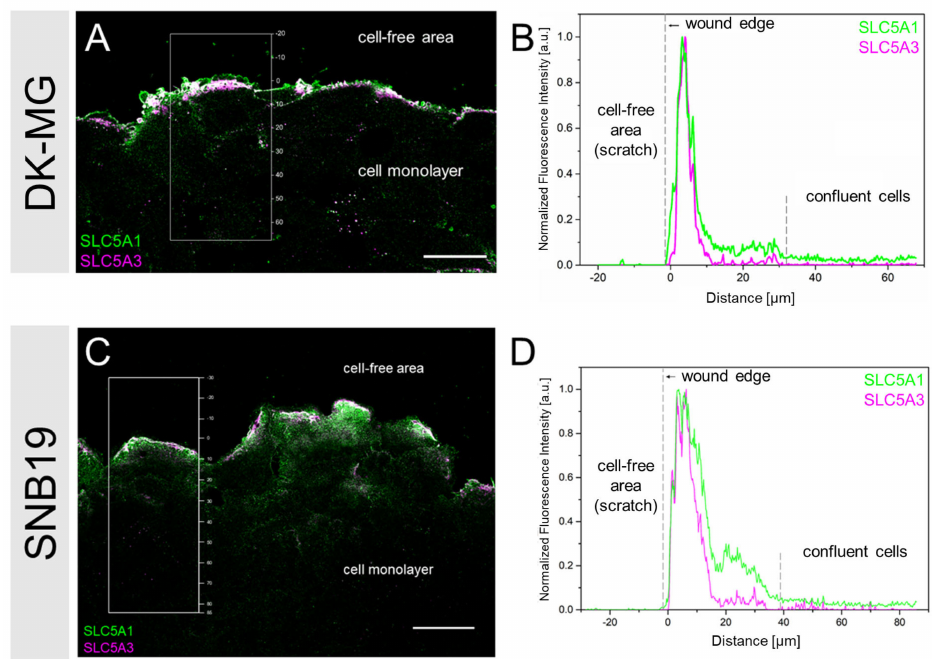
Figure 3. Representative LSM images of a DK-MG ( A ) and a SNB19 ( C ) cell monolayer, stained for SLC5A1 and SLC5A3 3 h after wounding. ( B , D ) Intensity profiles of the boxed area in A and C. Cells at the wound edge (0–~35 µ m) display marked fluorescence signal peaks facing the cell-free area. In contrast, confluent cells were almost devoid of SLC5A1 and SLC5A3 signals. Scale bar in ( A , C ): 30 µ